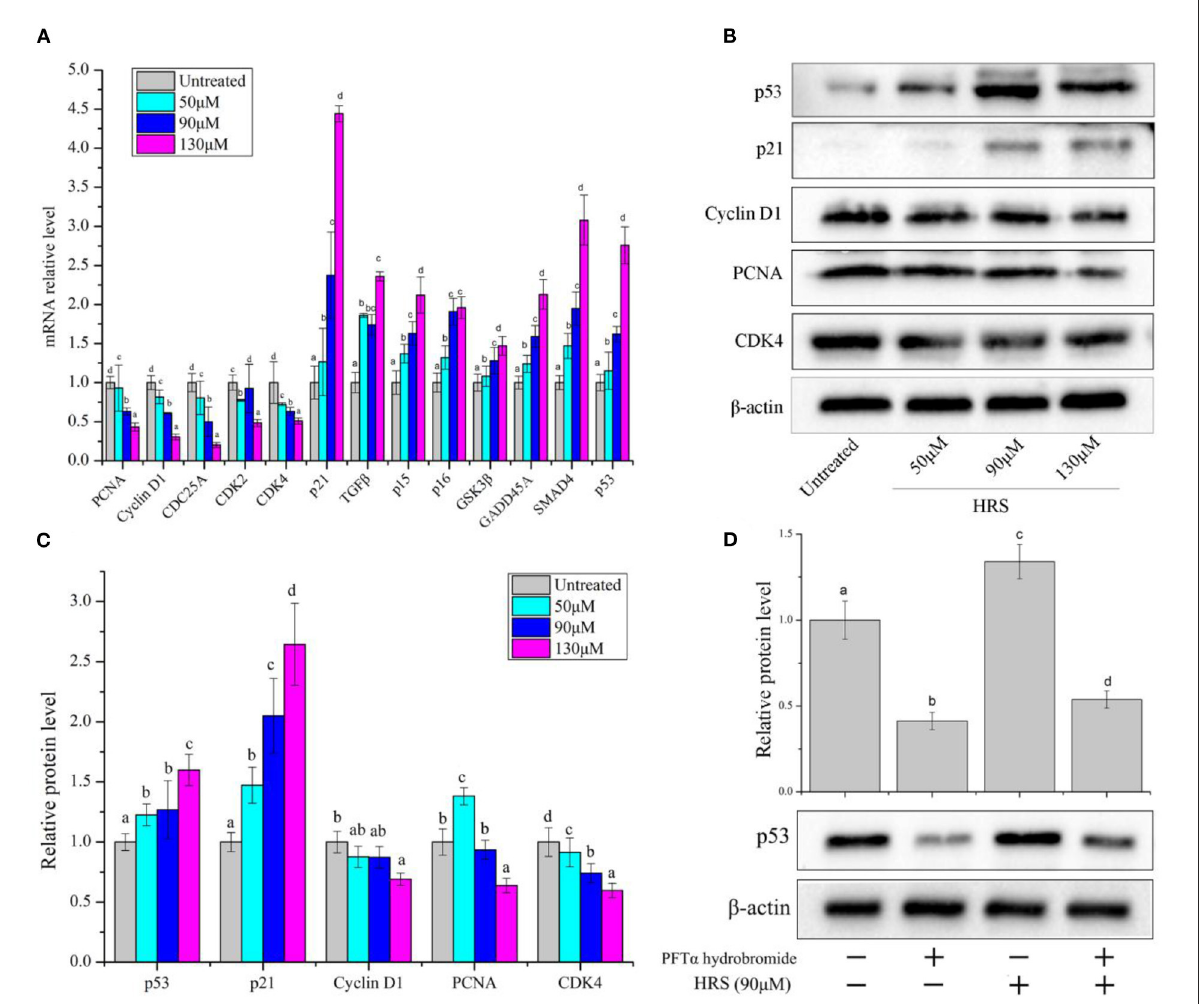
FIGURE6 Expression of cell-cycle related protein and genes in HCT-116 cells after treatment with hydroxy- γ -sanshool (HRS). (A) Relative mRNA level of related genes in HCT-116 cells. (B) Western blot of effects on HRS on cell-cycle related proteins in HCT-116 cells. (C) Levels of cell-cycle related proteins. (D) Protein level of p53 in HCT-116 cells, with or without a p53 inhibitor (PFT α hydrobromide). HCT-116 cells were treated with HRS at designated concentrations and compared to untreated cells. All data were expressed as means ± SD for three replicated experiments. a − d Within a cluster, columns without a common superscript differed ( p <